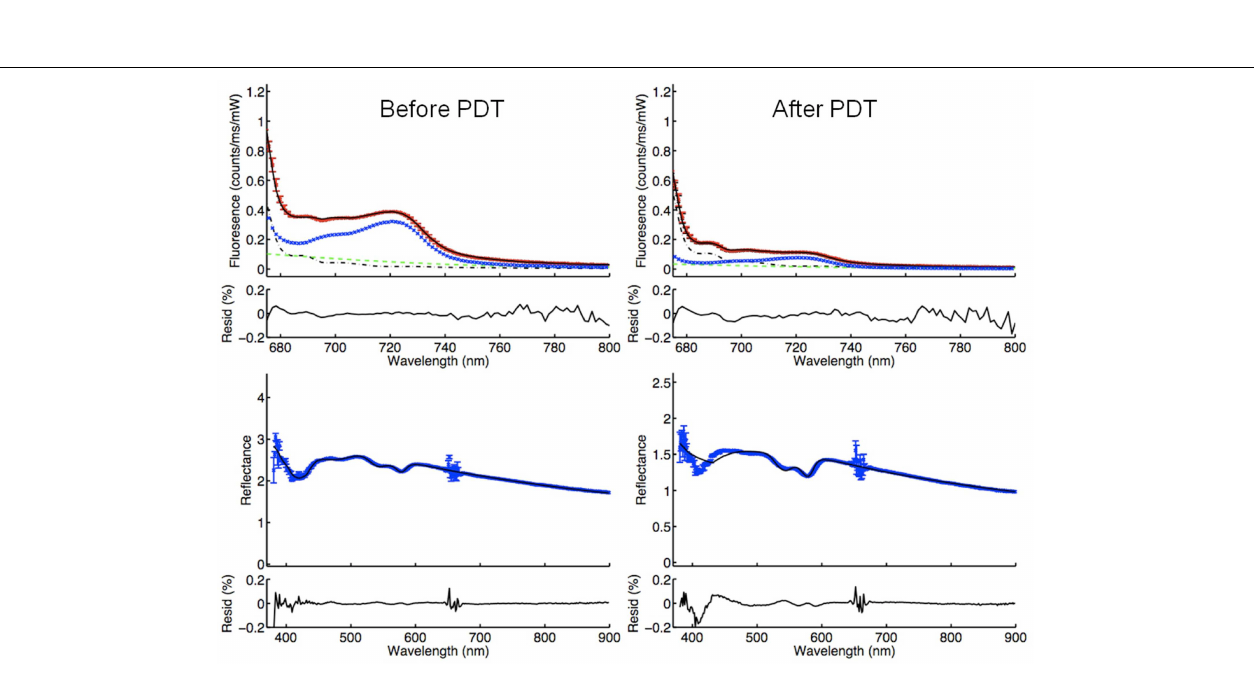
FIGURE 4 | FDPS (above) and DPS (below) spectra measured before and after PDT, demonstrating the anticipated photobleaching. The blue line in the fluorescence spectra (above) represents the fluorescence